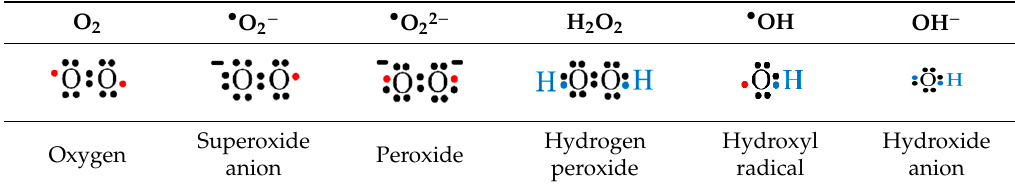
Table 2. Lewis structure of molecular oxygen, and fundamental reactive oxygen species formed in the mitochondrial respiratory engine of the cell.